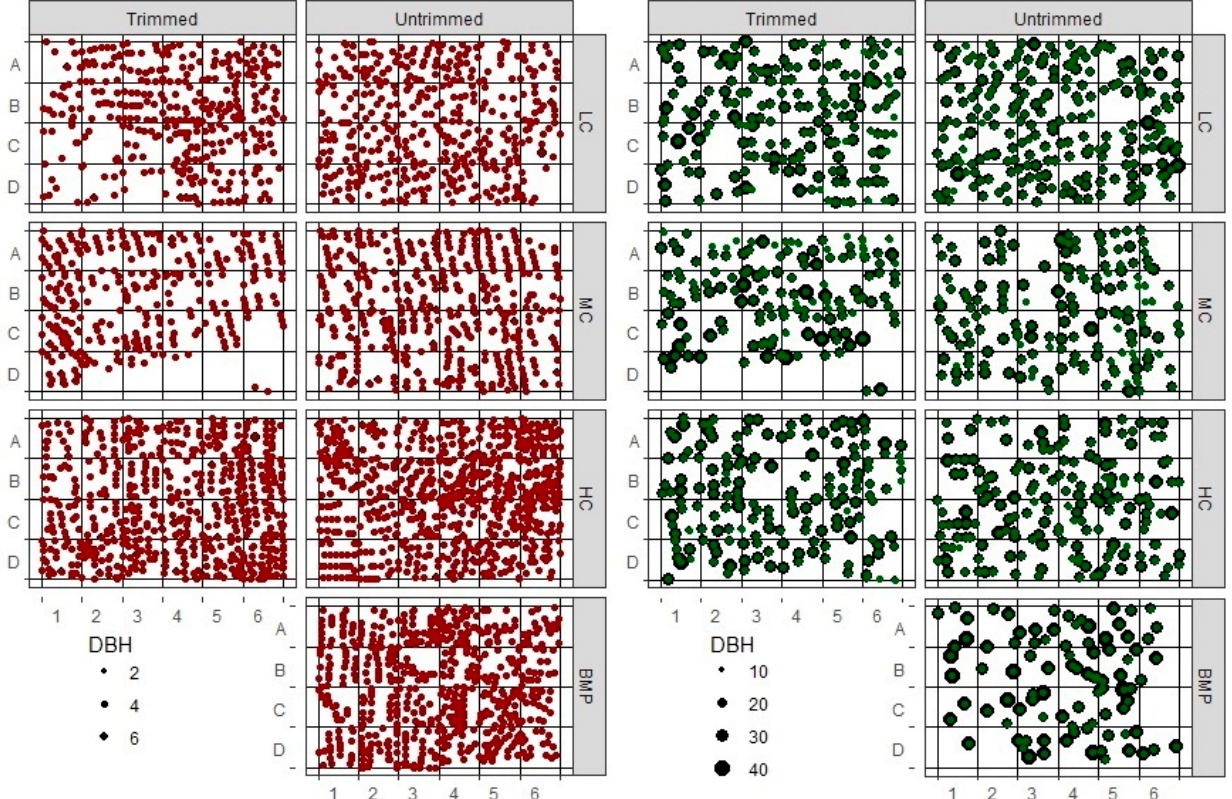
Figure 5. Location and size of all coffee plants and pine trees within the plots. The area of low plant density in MC trimmed plots located in grids D2–D6 and C6 is due to the presence of a small seasonal stream. Whilst this area is still shaded by the surrounding trees it has been excluded from subsequent experiments and statistical analysis of baseline metrics. Table 1. Summary of key plot characteristics measurements and comparison of plot level differences using one way Anova and Tukey post hoc testing of significant main effect. Same superscript letters indicates no significant difference in comparison of plot level values. Means are based on a per grid value ( n = 24) and excludes MC trimmed plot grids D1–6 and C6. Post-trimming canopy cover per- centage cover values are preliminary as they are based on one measurement per grid in contrast to the 5 measurements per grid taken pre-trimming .